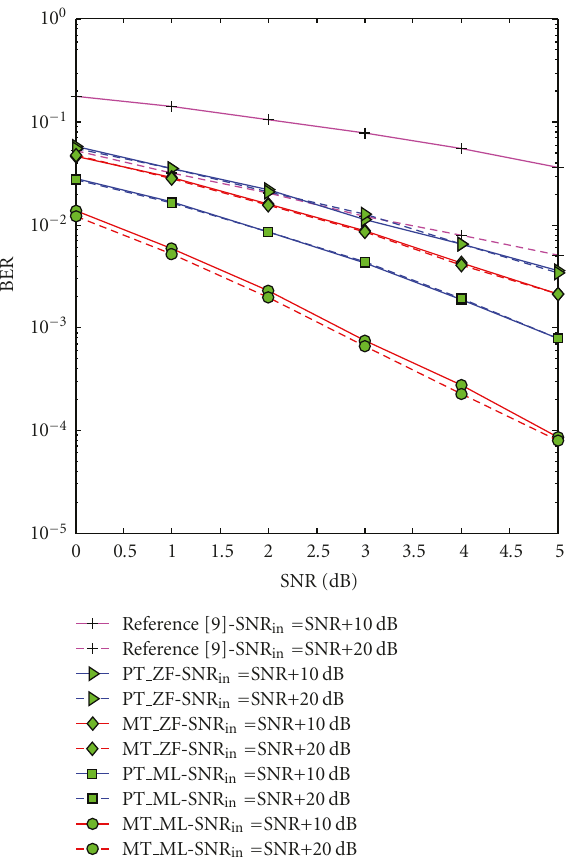
Figure 9: BER versus SNR with di ff erent interuser channel qualities and SNR rd = SNR +